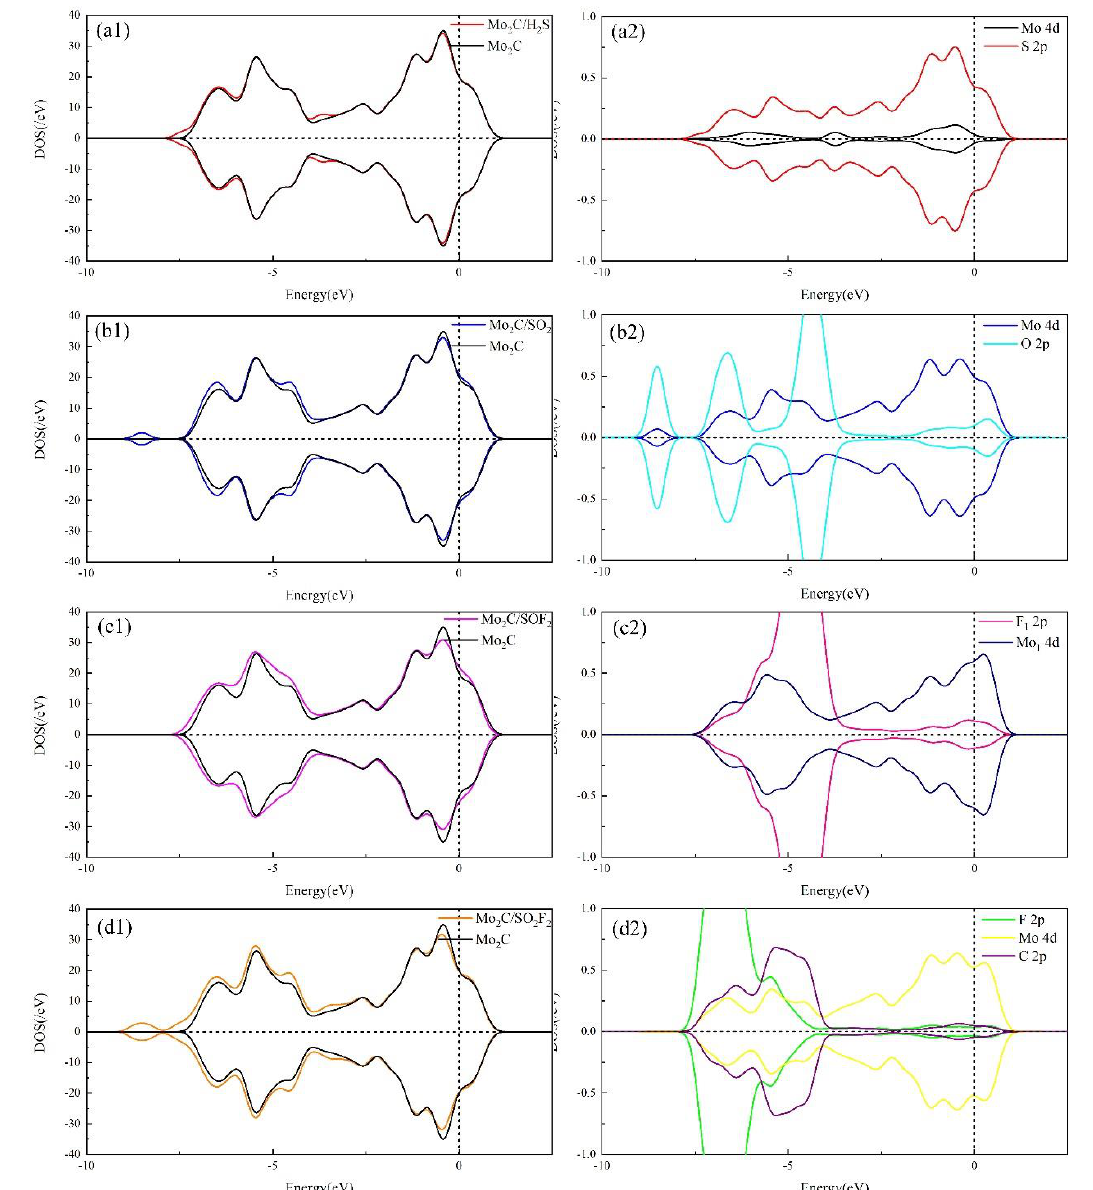
Figure 5. DOS of H 2 S ( a1 , a2 ), SO 2 ( b1 , b2 ), SOF 2 ( c1 , c2 ) and SO 2 F 2 ( d1 , d2 ) systems. The dash line is the Fermi level.